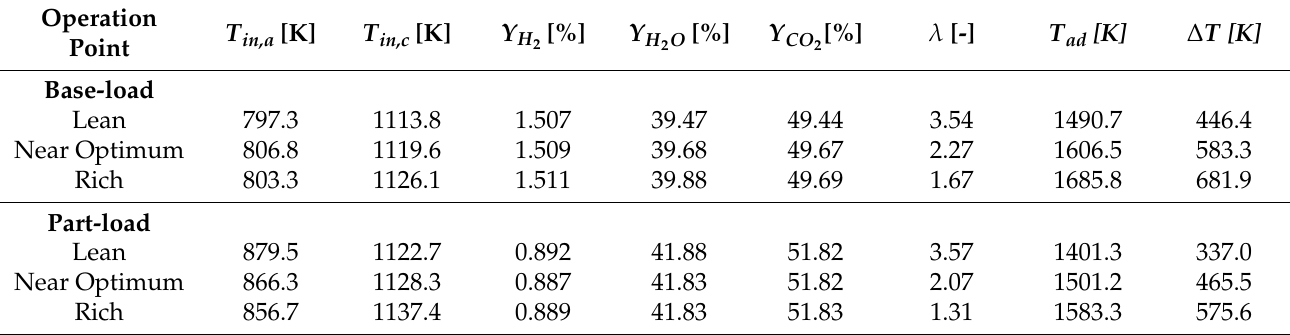
Table 1. Combustion system operation conditions in the context of post-SOFC alignment. Y i : Mass fractions of fuel composition, ∑ Y i = 1. T in , a , c : Inlet temperatures of anode (fuel) and cathode (air). T ad : Adiabatic flame temperature, ∆ T : Expected temperature capacity by combustion. Values were measured in the test rig. Measurement uncertainties in Table